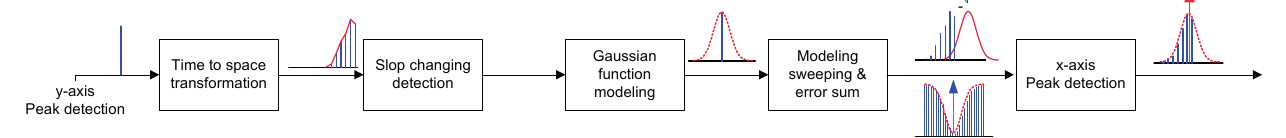
Figure 9. Signal processing flow chart for peak detection using compensation for time delays in the x axis (driving direction of the